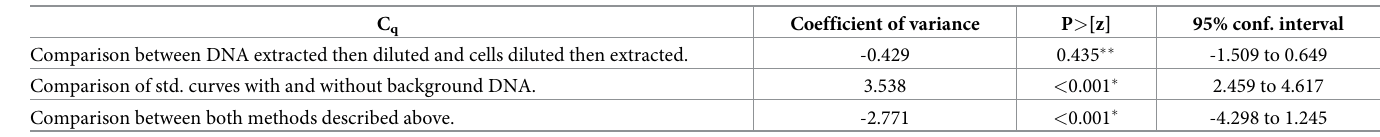
Table 3. Statistical analysis between the four standard curves.